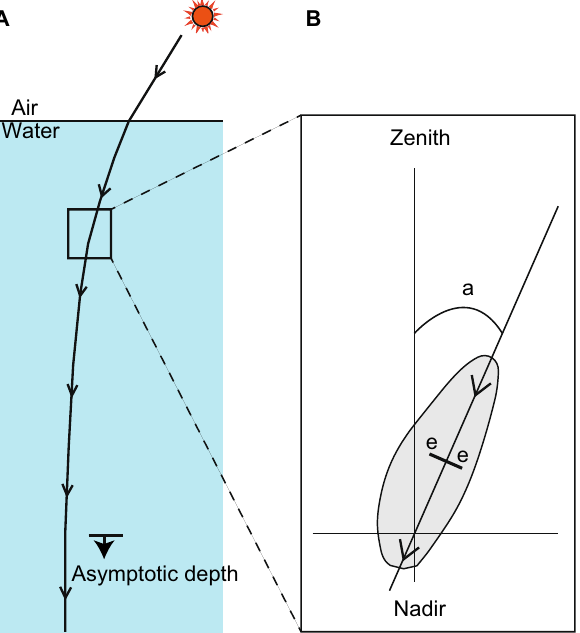
Figure 7. Optical features of underwater sunlight. ( A ) Schematic diagram of sunlight penetrating the deep ocean at 90° to the solar bearing. The line of arrows indicates the major axis of the incident beam in a vertical plane perpendicular to the Sun’s bearing. Blue light (around 475 nm) reaches the lowest depths. With increasing depth, the light field alters its character into a less directed distribution and a lower energetic level through scattering and absorption processes. Penetrating light rays are symmetrical around the region below the asymptotic depth. ( B ) An example of spectral radiance distribution (e. g. 475 nm) at a certain depth. The radiance distribution is shown by an ellipsoid and the major axis is drawn by a line with arrow. The refracted angular deviation (a) of the major axis of underwater radiance distribution from the vertical axis equals the tilt of the electric vector (ee bar) from the horizontal axis 53 . When the Sun’ s elevation was 60° in the Sargasso Sea, the radiance distributions were measured at three different depths and the tilt of the electric vector were estimated to be 24° at depths of 100 m and 200 m and 13° at depth of 400 m 52, 53